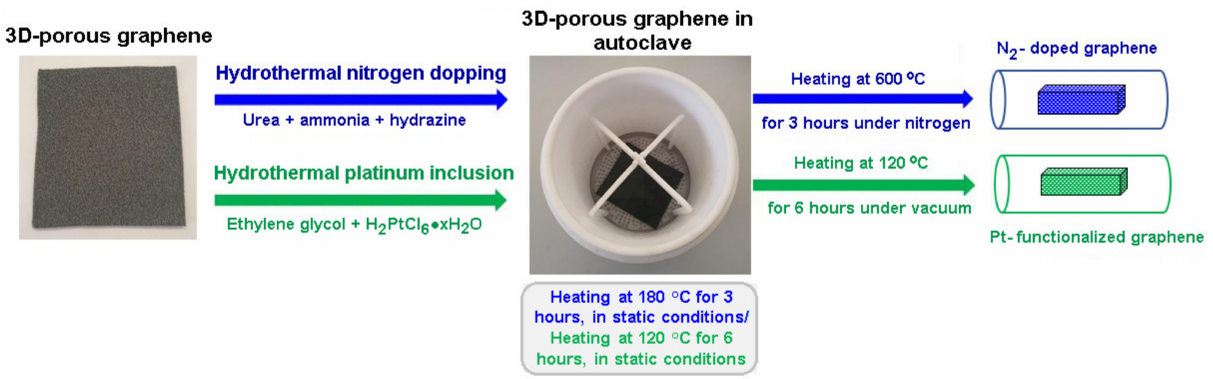
Figure 1. Scheme of the hydrothermal nitrogen doping and platinum functionalization of the 3D-porous graphene